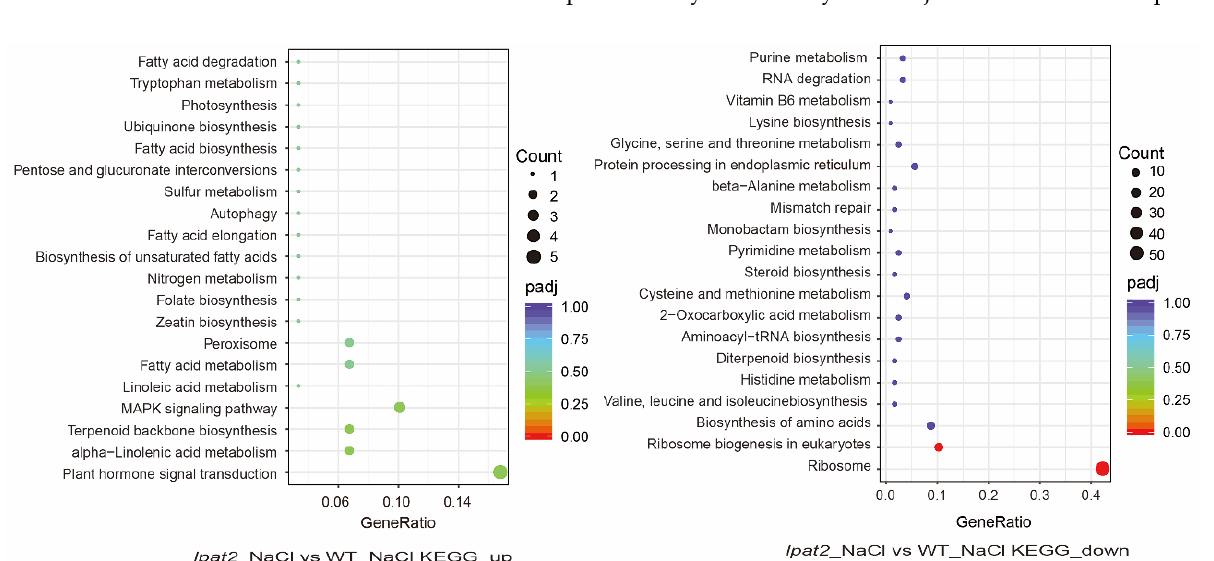
downregulated genes of lpat2 vs. WT under control condition. ( D ) The numbers of upregulated and downregulated genes of lpat2 vs. WT under NaCl stress condition. Red dots represent upregulated genes and green dots represent downregulated genes. The total RNAs were extracted from leaves of three-week-old plants treated without (control) or with 100 mM NaCl for 12 h for RNA-sequencing .